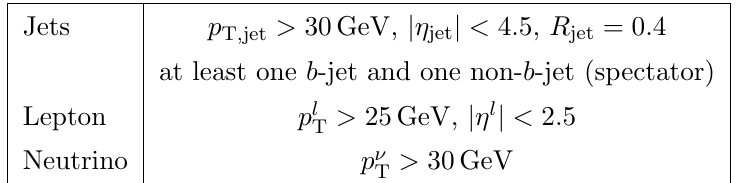
p s = 13 TeV, m O.S. = 173 GeV, (cid:22) X = t